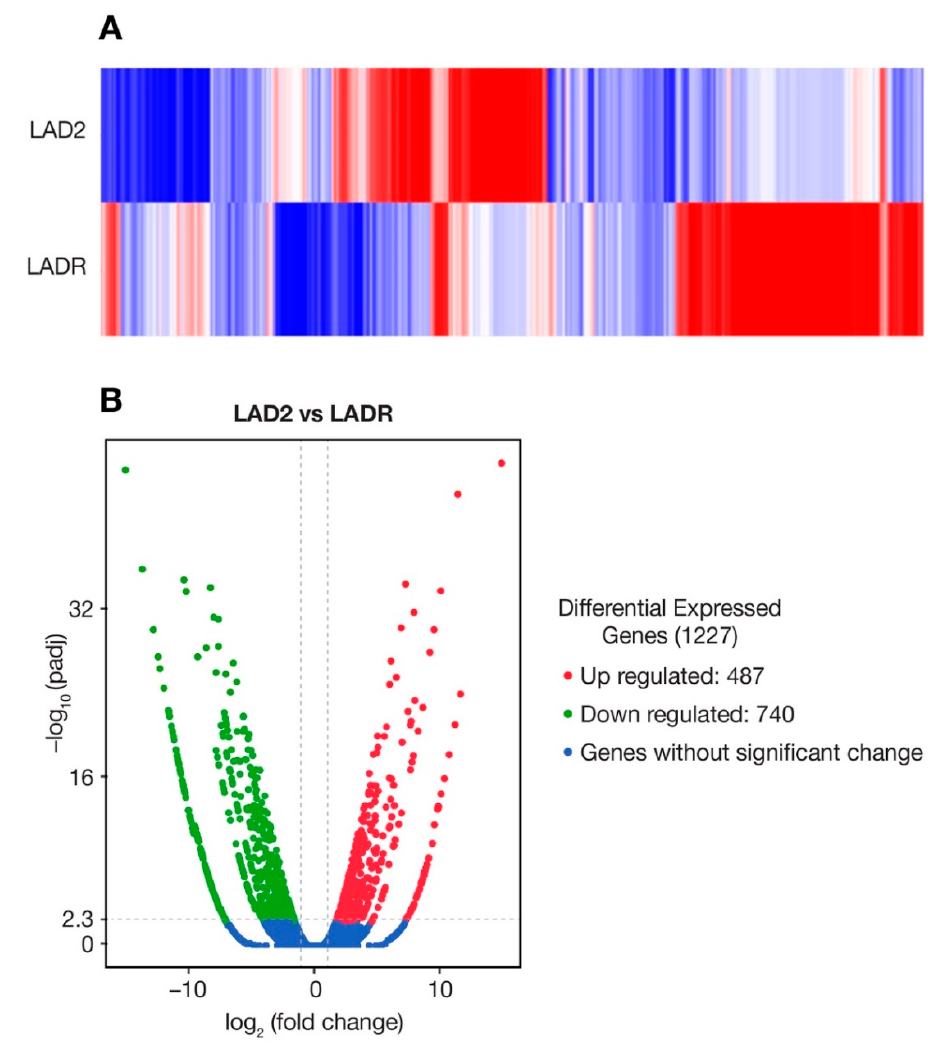
Figure 4. Differential gene expression of LADR cells compared with LAD2 cells. ( A ) Heat map showing differentially expressed and upregulated genes (red) when comparing LADR to LAD2 cells. Downregulated genes are shown in blue, genes without significant change are shown in white. ( B ) LADR cells expressed over 400 upregulated genes (red) when compared with LAD2 cells. Genes without significant change are shown in blue.